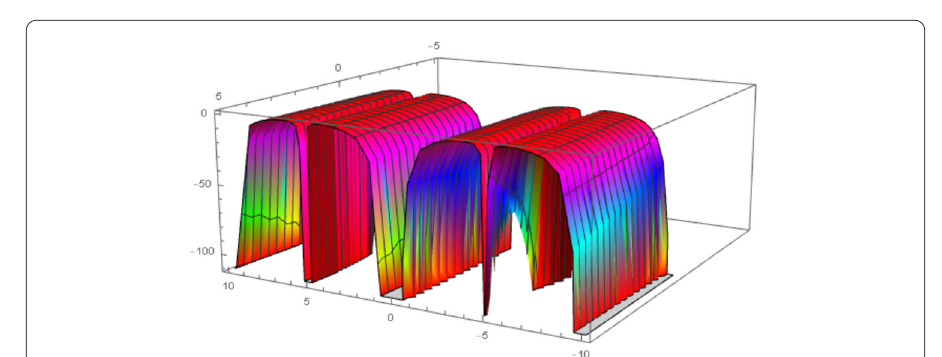
Figure 2 Multiple soliton solution of u 3 ( η ) for α = 0.25, a 1 = 11, λ = 1, V = 12, b 1 = 11, μ = 3